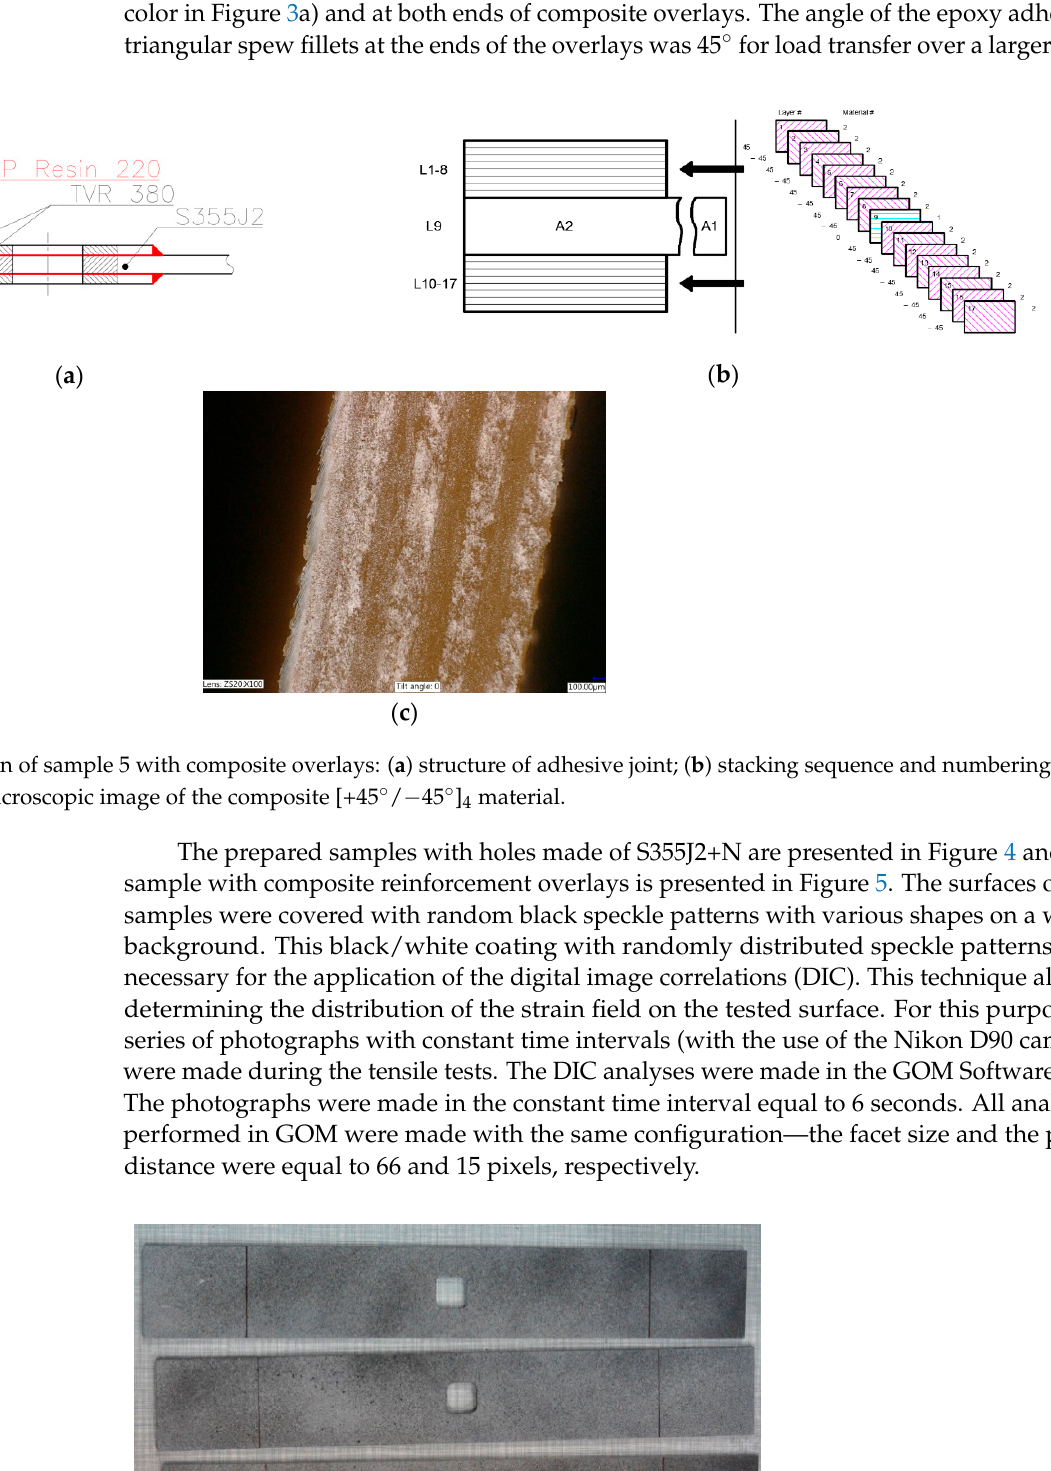
Figure 5. Photograph of sample 5 with composite reinforcement overlays at the center and covered by speckle pattern.